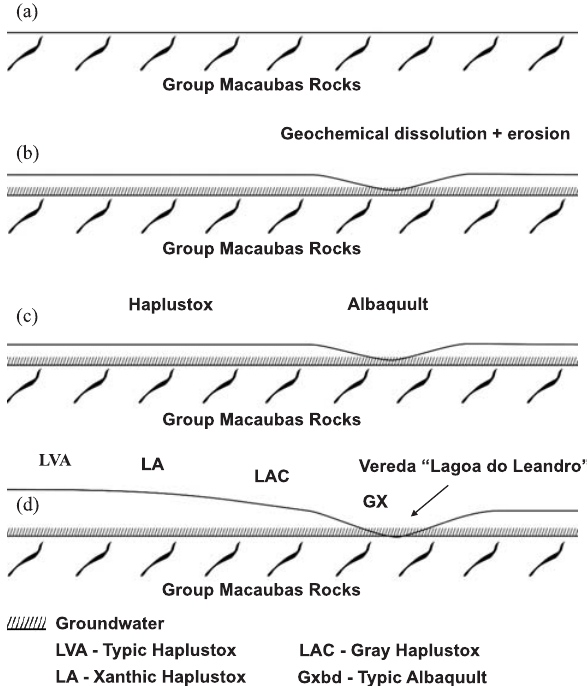
Figure 9. Proposed model of landscape evolution of drained vereda-microbasins on highlands of the Jequitinhonha